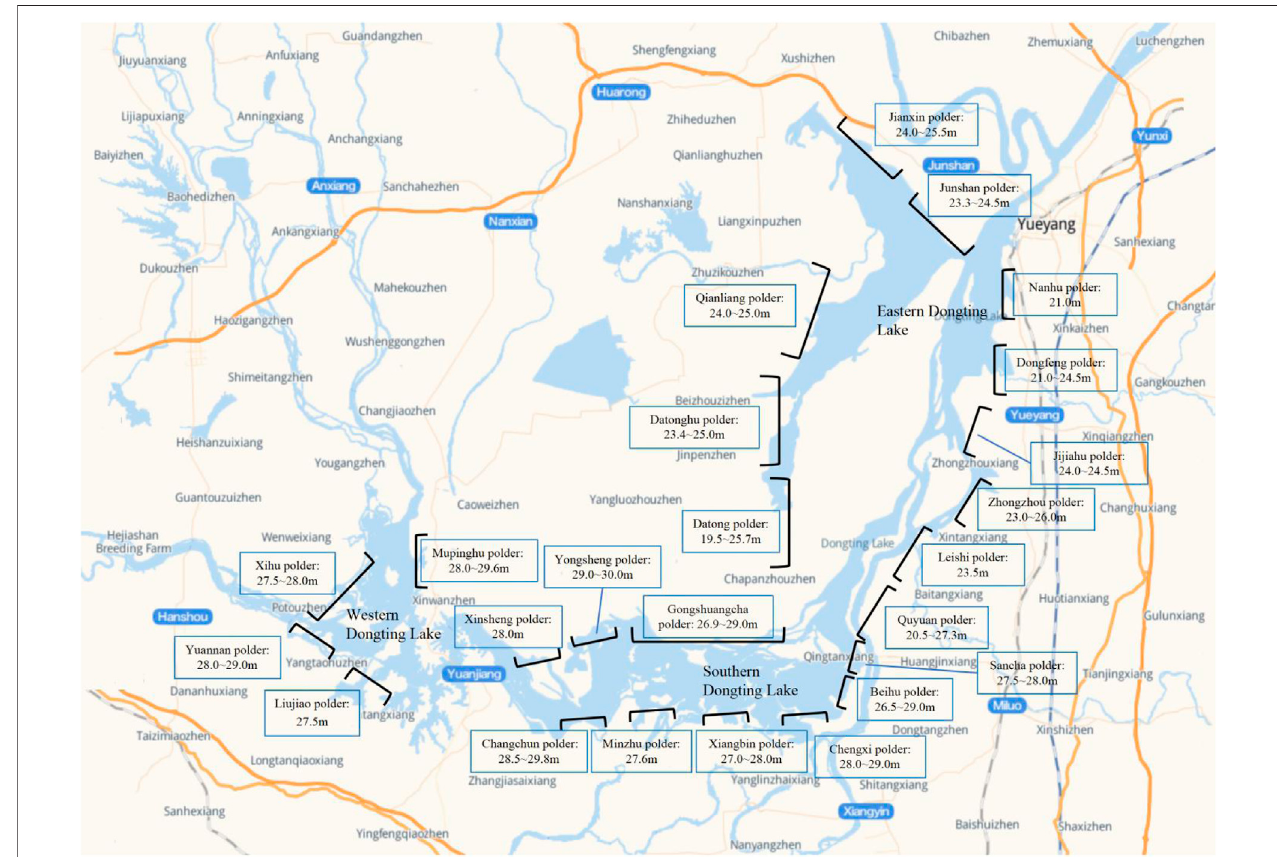
FIGURE 11 | Required water levels for irrigation of the polders in the Dongting lake.